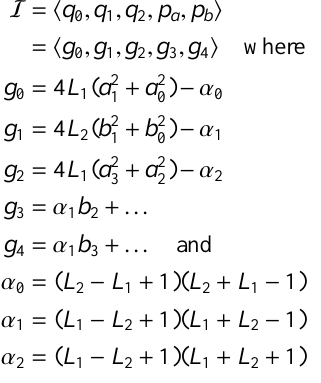
Figure 2. The choices of local coordinates for 4 bar mechanism. The arrow indicates the direction of e 1 for each